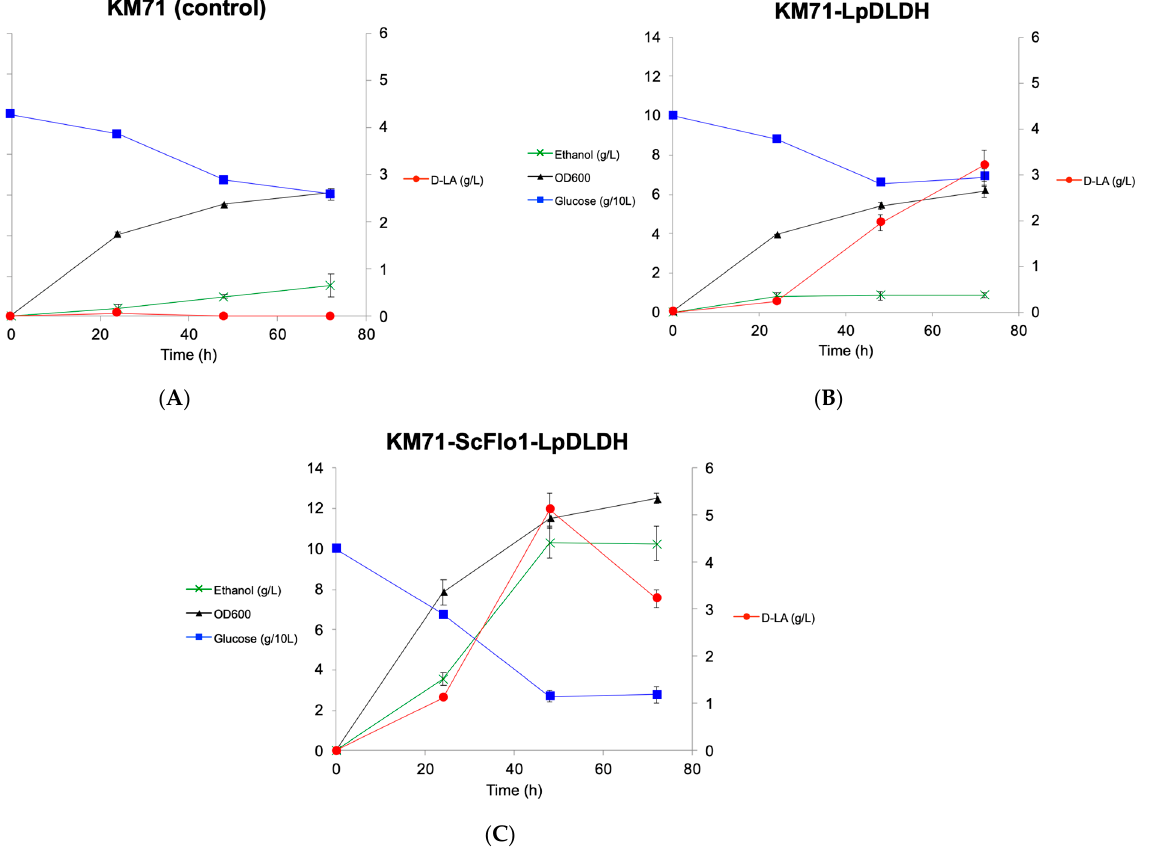
Figure 5. D -lactic acid production in the engineered P. pastoris strains: KM71 (control) ( A ), KM71- LpDLDH ( B ), and KM71-ScFlo1-LpDLDH ( C ). Values represent the mean of three biological replicates ± standard deviation ( n = 3).